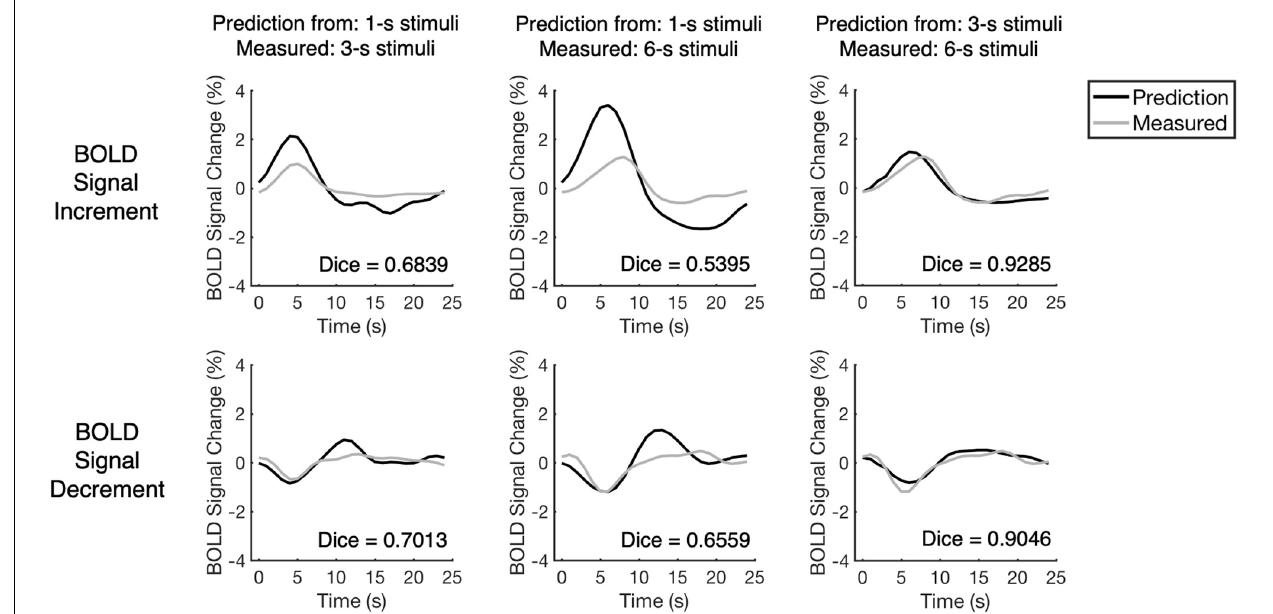
FIGURE 3 | The comparison between measured BOLD responses and their linear predictions for one representative voxel. The voxel is the same as the one presented in Figure 2 . The BOLD responses and their temporally shifted copies were added up linearly to predict the BOLD responses to longer stimuli. As the measured BOLD responses and their linear prediction have high similarity, the performances of BOLD responses to longer stimuli were close to linear. The Dice index is a similarity index that ranges from –1 to 1 in which, higher Dice index indicates higher similarity between measured BOLD response and its linear